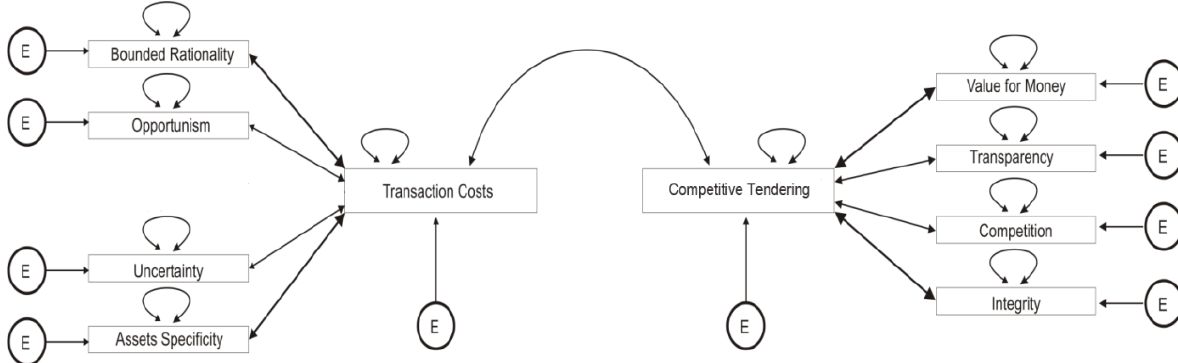
Figure 1: Factor Analysis Model of Transaction Costs and Competitive Tendering; Source: Proposer’s Own Construct Operationalisation of TCs and CTP Dimensions